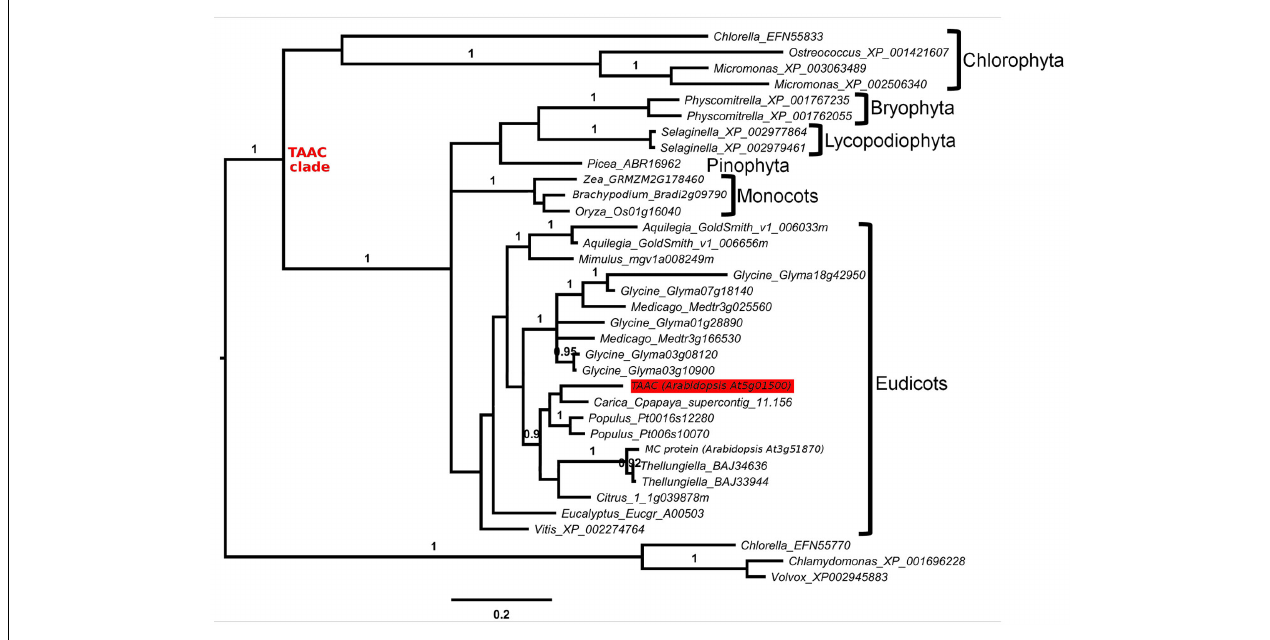
to which each subclade belongs is indicated.The position of Arabidopsis TAAC is highlighted in red.The scale bar indicates substitutions per site. Posterior probabilities ≥ 0.90 of clades, analyzed as in Figure 1 , are shown above branches.The results discussed are robust to an alternative alignment (MAFFT, not